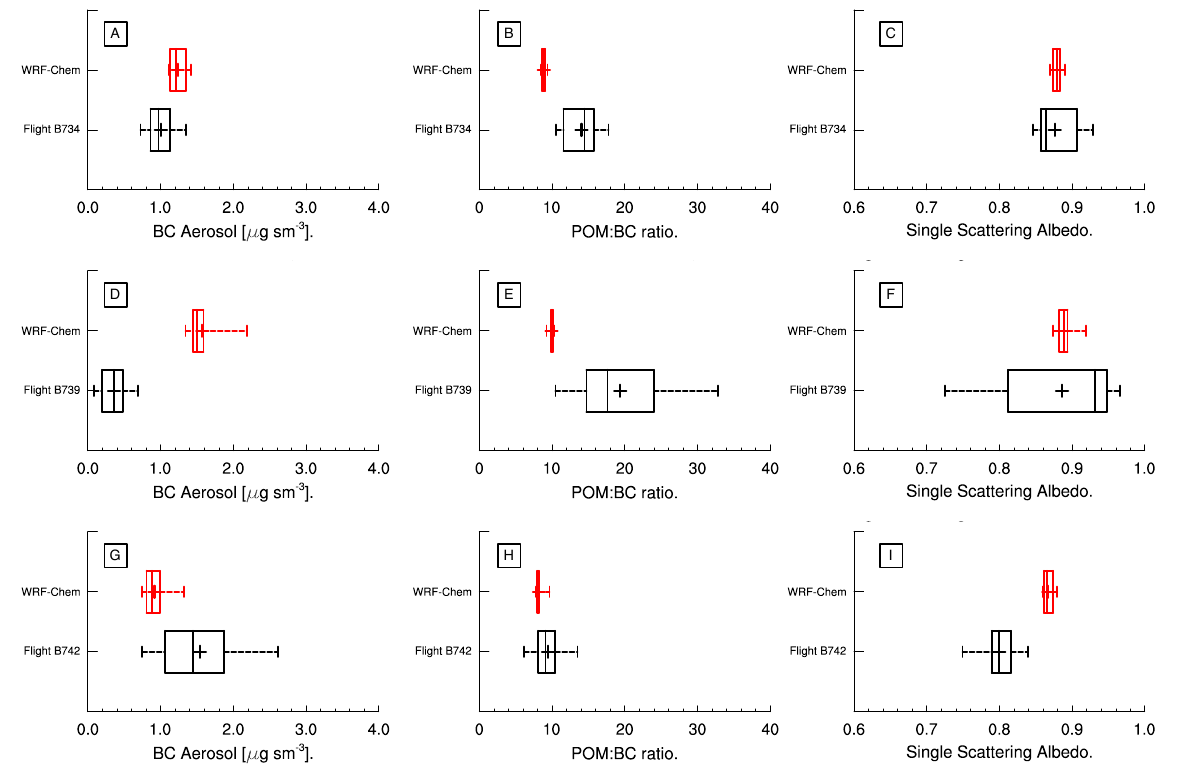
Figure 9. Box-whisker plots of black carbon (BC, µgsm − 3 ), particulate organic matter to black carbon ratio (POM:BC) and single scattering albedo ( ω 0 ). Box bounds show interquartile range, the end of dashed lines the fifth and ninety-fifth percentiles, and cross indicates the mean. Showing spread of data from flights and extracted along flight path from modified emissions WRF-Chem run. Screened to only show data from straight-level runs below 3.25kma . s . l . . Flight data averaged over 3min periods (approximately the time taken to travel across one 25km grid cell). Panels ( a , d and g ) are for flight B734 (18 September); panels ( b , e and h ) for flight B739 (23 September); and panels ( c , f and i ) for flight B742 (27